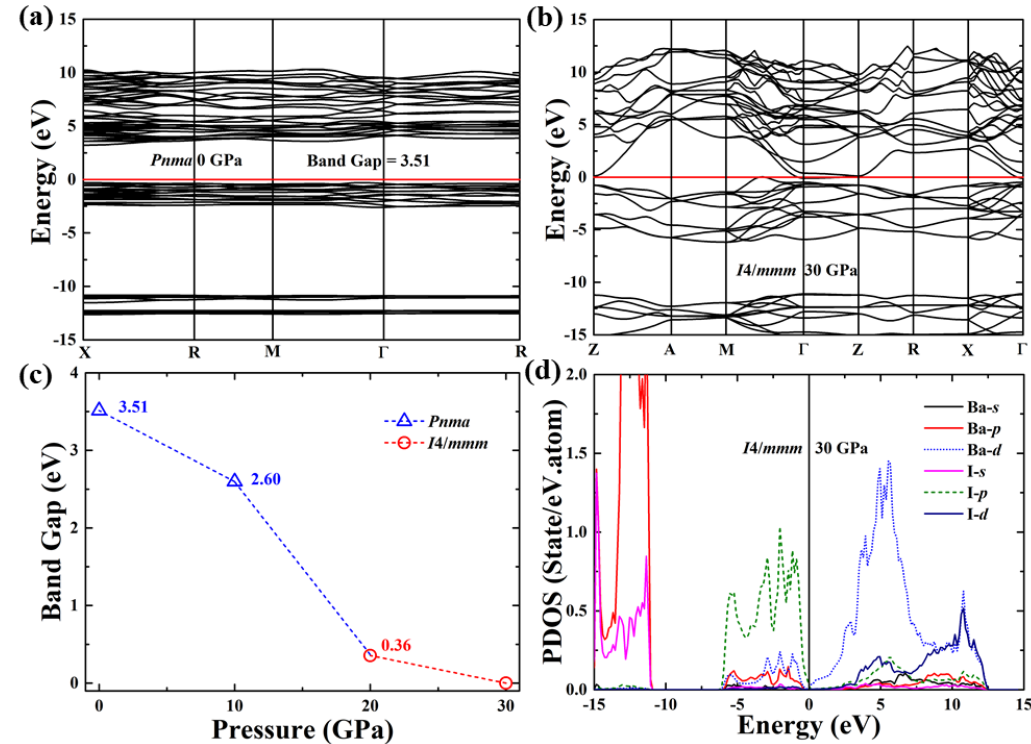
Figure 4. Calculated electronic band plot along high-symmetry directions of Pnma BaI 2 at 0 GPa ( a ) and I 4/ mmm BaI 2 at 30 GPa ( b ). Pressure dependence of theoretical band gaps of BaI 2 ( c ). Electronic density of states of I 4/ mmm BaI 2 at 30 GPa ( d ).